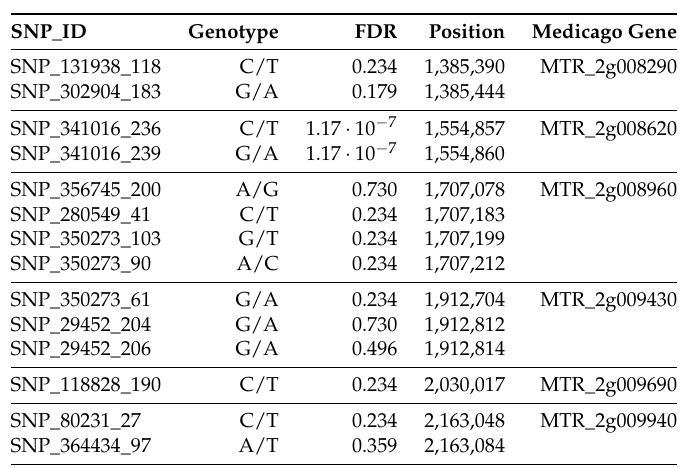
Table 4. The 14 SNPs found in the predicted promoters of Vicia faba that were mapped to the Medicago truncatula target genomic